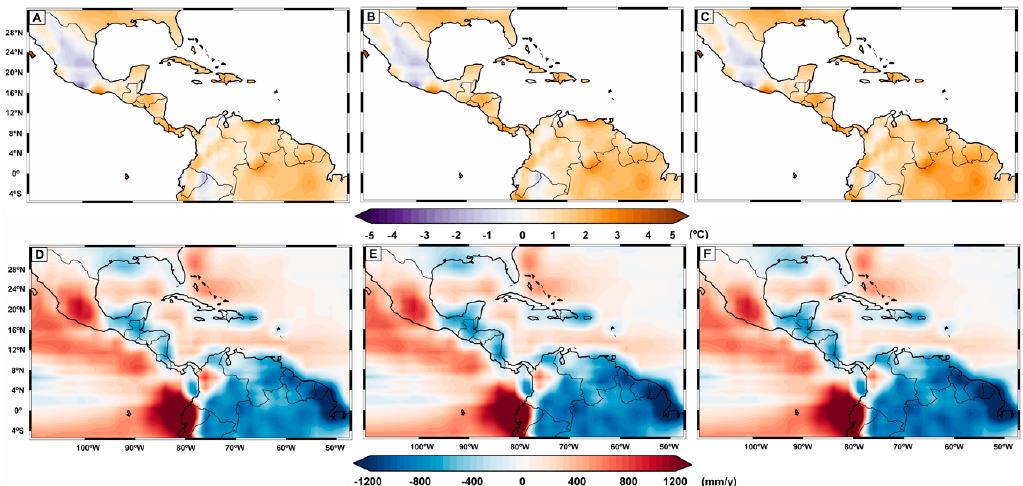
Figure 9. Surface temperature anomalies from multi–model mean (CanESM5, CESM2, CNRM–CM6–1, MPI–ESM) under the ( A ) SSP1–2.6, ( B ) SSP3–7.0, and ( C ) SSP5–8.5 for the 2021 – 2050 period, in reference to the baseline between 1980 and 2009 from the gridded CRU TS v.4.04 dataset and rainfall anomalies under the ( D ) SSP1–2.6, ( E ) SSP3–7.0, and ( F ) SSP5–8.5 for the 2021–2050 period, in reference to